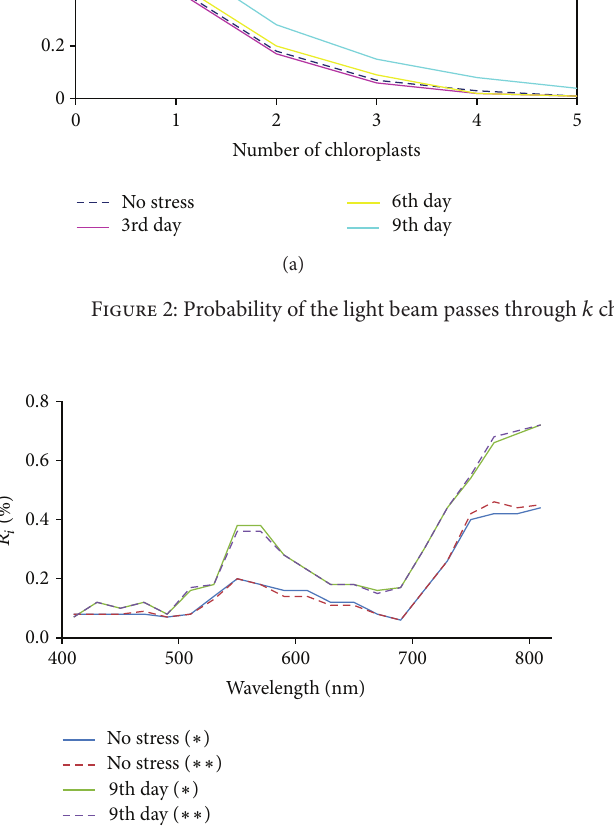
Figure 3: Comparison of the experimental and theoretical inter- nal reflectance spectrum of Spring barley stressed by dryness.